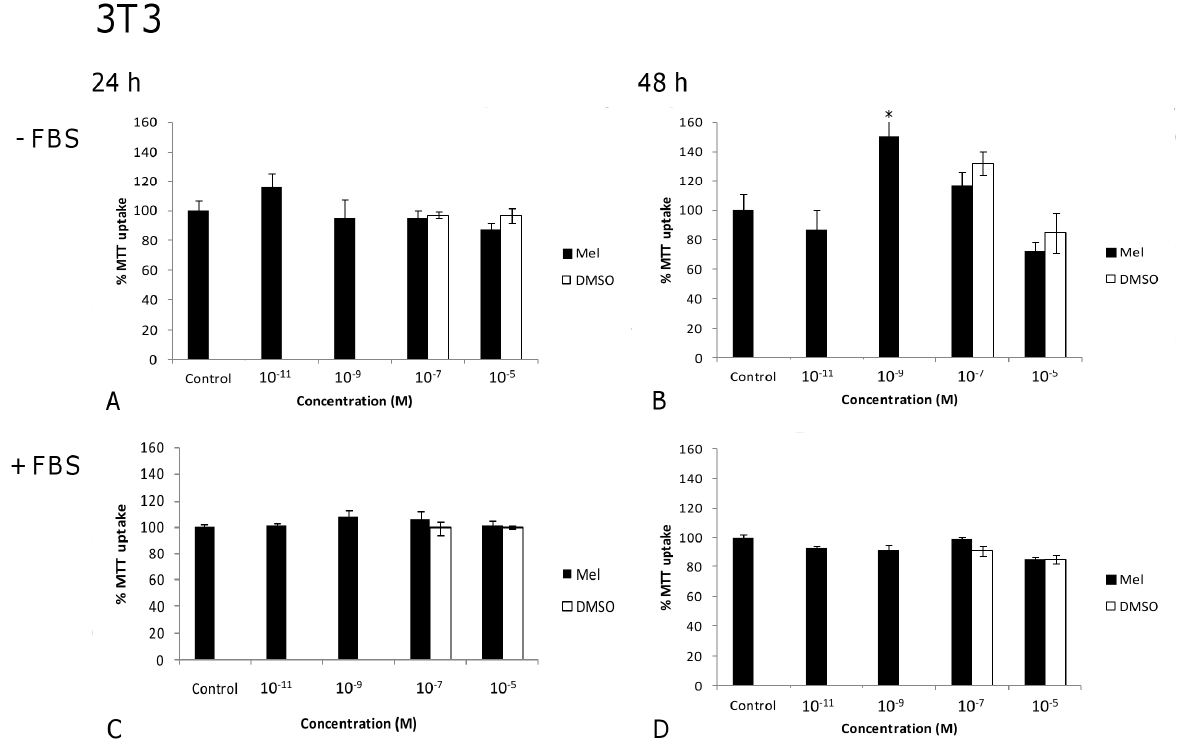
Figure 2. Fibroblast cell line (3T3): Effects of melatonin on counts of viable cells (expressed as the percentage of MTT uptake with respect to the untreated control), in a low concentration range, in the absence ( A and B ) or the presence ( C and D ) of fetal bovine serum (FBS) after 24 ( A and C ) and 48 h ( B and D ) of treatment. DMSO vehicle controls were performed for each melatonin concentration, although for terms of clarity only the two highest concentrations are represented. Statistically significant differences compared to controls are marked with asterisks. (* indicates p < 0.05, ANOVA followed by Dunnett’s post hoc